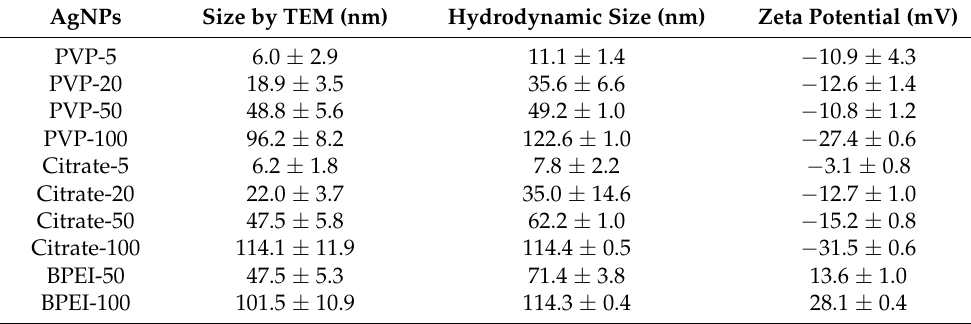
Figure 1. HRTEM image of AgNPs. ( A – D ) The morphology of PVP-coated AgNPs with different particle sizes: 5 nm ( A ), 20 nm ( B ), 50 nm ( C ), and 100 nm ( D ); ( E – H ) the morphology of citrate- coated AgNPs with different particle sizes: 5 nm ( E ), 20 nm ( F ), 50 nm ( G ), and 100 nm ( H ); ( I , J ) the morphology of BPEI-coated AgNPs with different particle sizes: 50 nm ( I ) and 100 nm ( J ). Table 1. Characteristics of AgNPs.